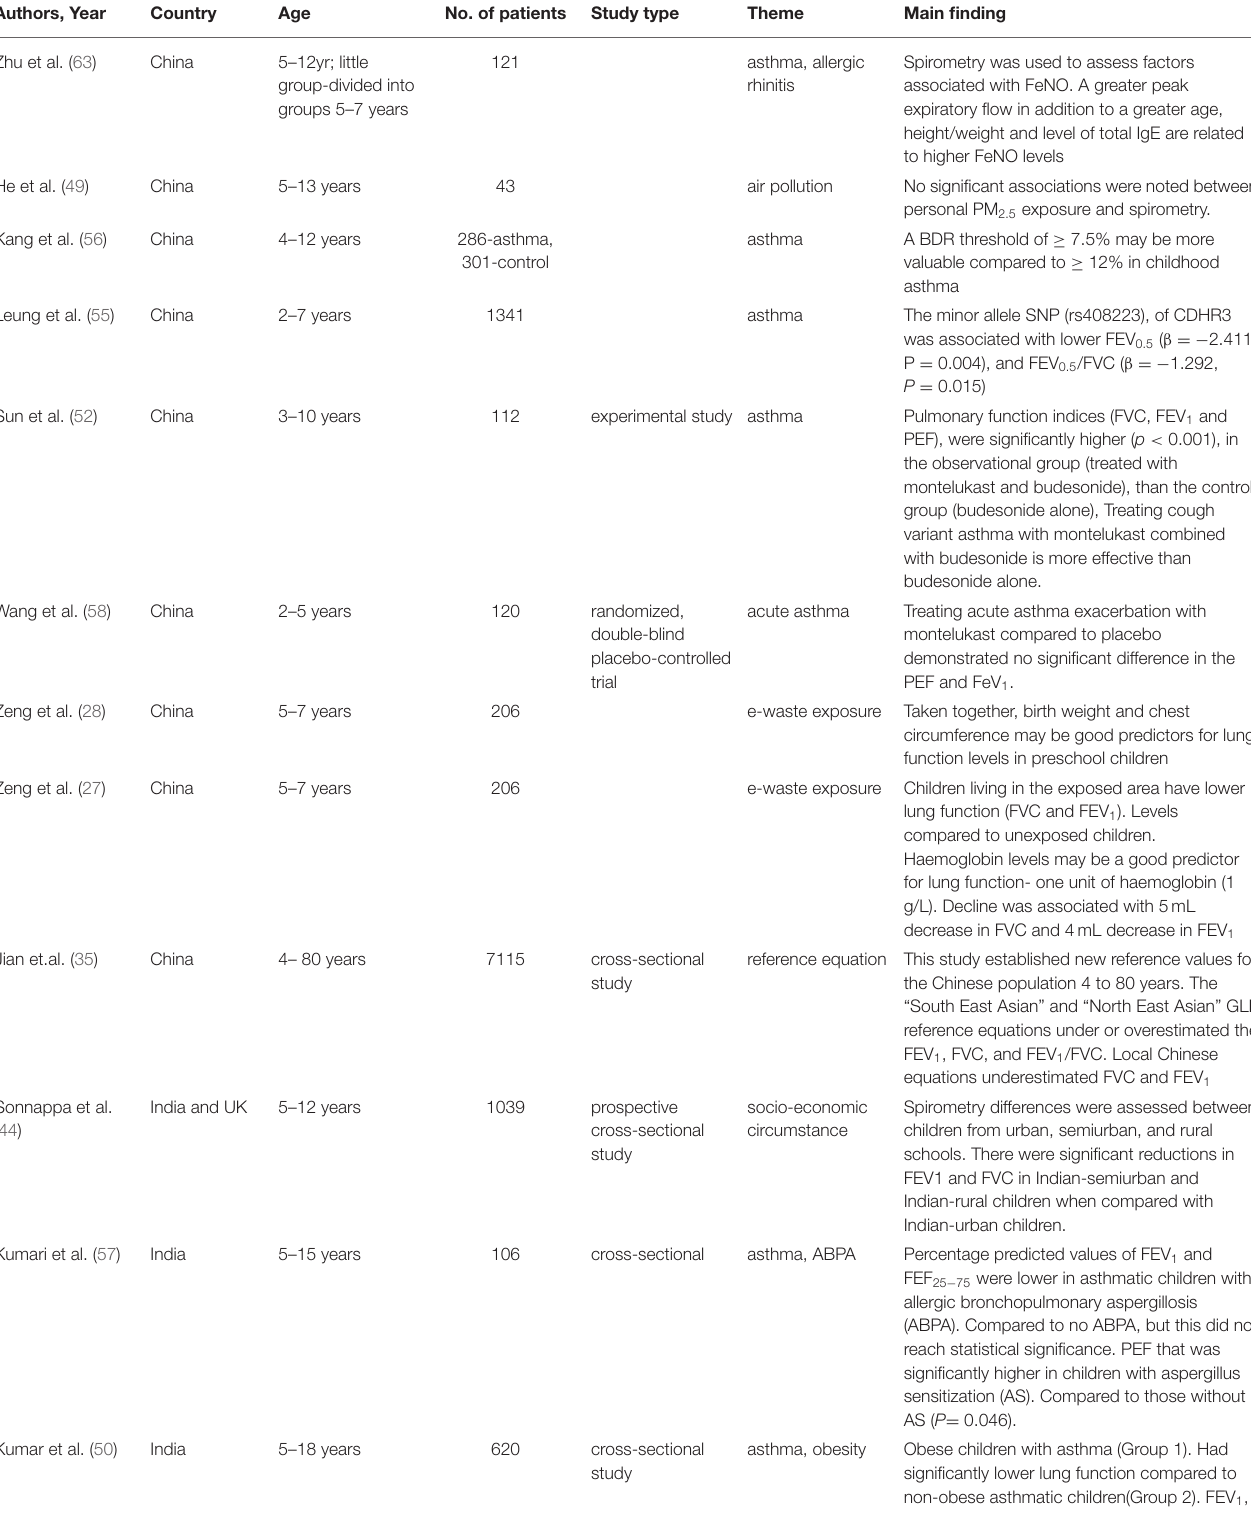
TABLE 1 | Details of included studies using spirometry ( n = 40).